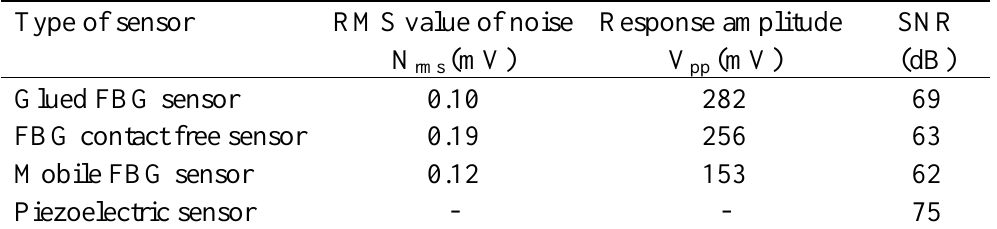
Table 1. Characteristics of FBG sensor responses to